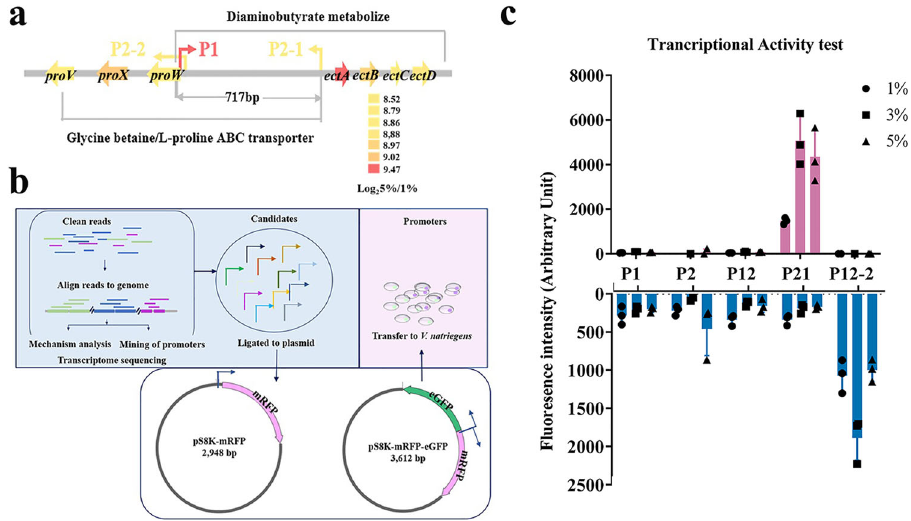
Fig. 2 Identi fi cation of salt-induced promoters. a Schematic of two up-regulated gene clusters, with three proposed promoters. (Color represents the up- regulation of the response genes; the sequences denote the proposed area for promoters, and the magni fi ed letters represent the start site for transcription). b Flow chart of the identi fi cation and characterization of the proposed promoters. c Detection of the fl uorescence intensity for mRFP/eGFP in the unit cell. P1 (400 bp gene sequence front cluster proWXV ), P2-1 (reverse 400 bp sequence front gene cluster ectBACD ), or P2-2 (reverse 400 bp sequence front cluster proWXV ), and the full-length interval area (P12, and its reversed sequence was P21). Error bars are standard error of mean.